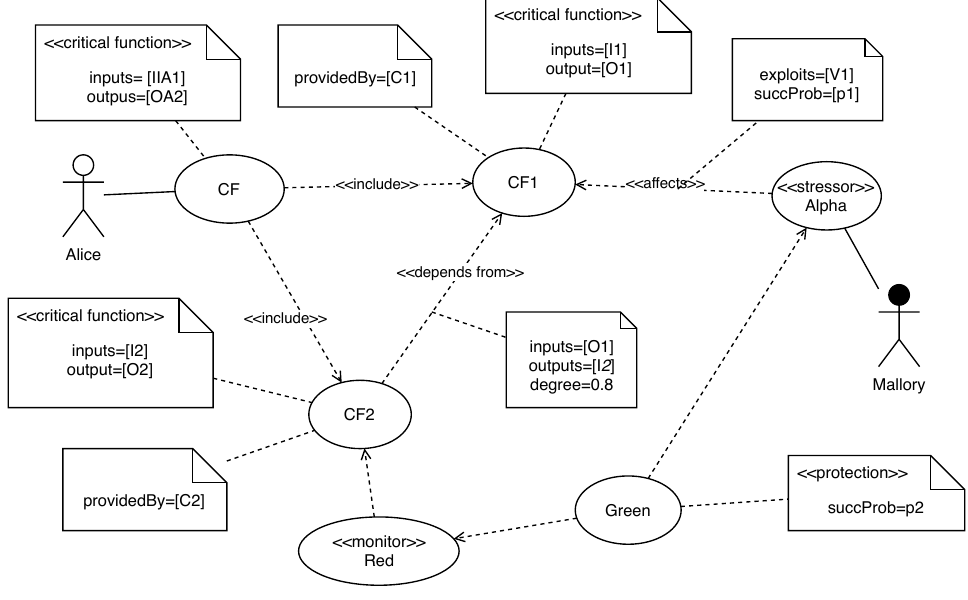
Figure 9. The functional